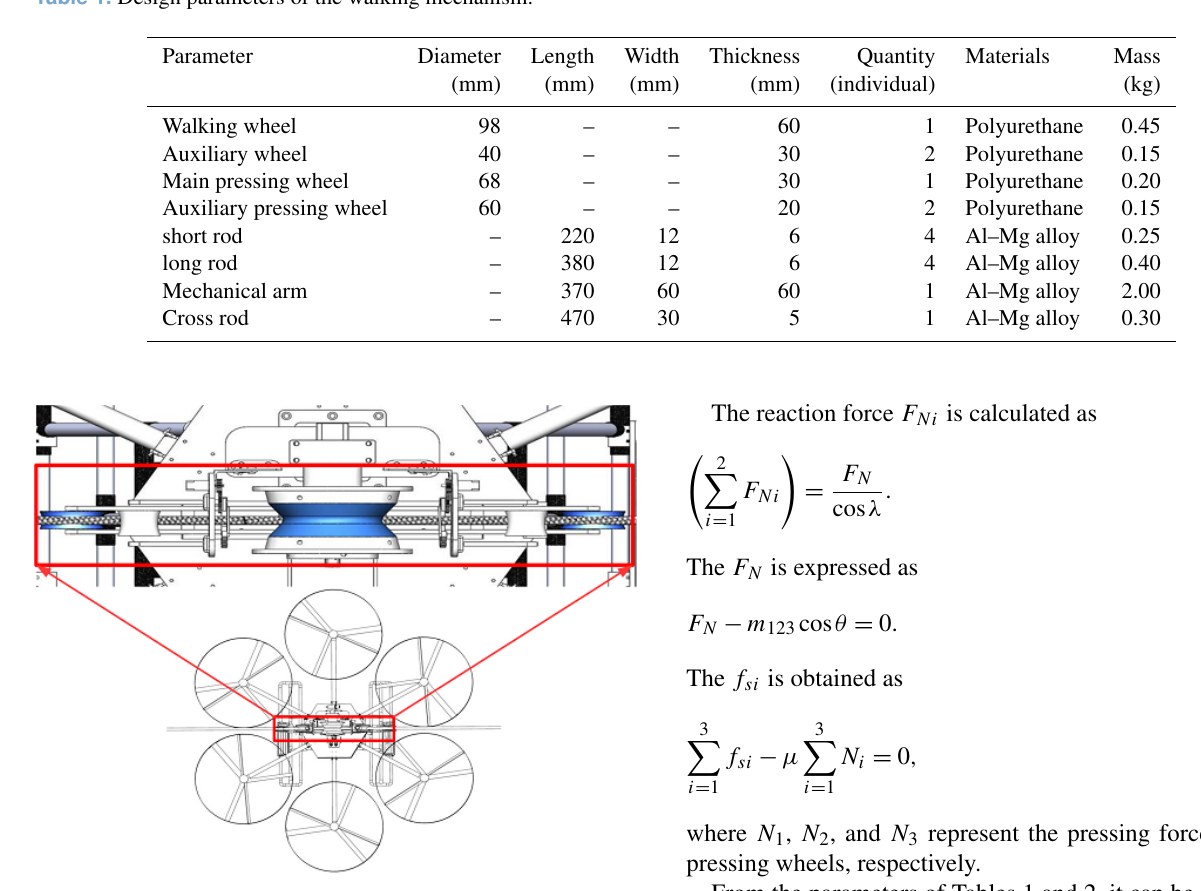
Figure 6. The top view of the FPLIR that illustrates the arrange- ment of the wheels on the power